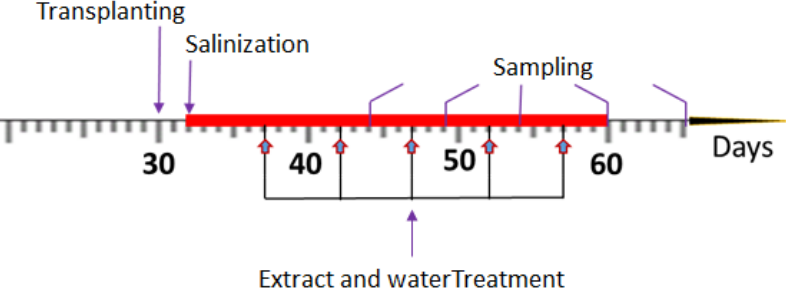
Figure 6. Scheme of treatment: Adapted from [54] and modified as deemed fit. Note. Salinity treatment was started on day 32 to day 60, and Roholtiella sp. extract and water treatment commenced at day 37 and continued at every five days intervals. Sampling was carried out on different days for the vegetative and biochemical analysis.